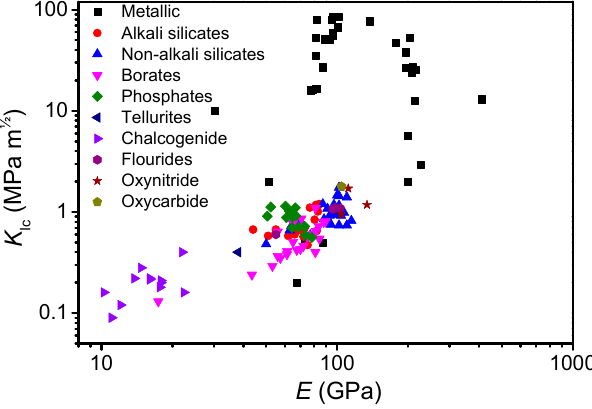
Figure 6. Dependence of measured fracture toughness ( K Ic ) on the measured Young’s modulus ( E ) for various glass systems (references are given in the text). Note that the axes are logarithmic. Errors in K Ic and E are estimated to be smaller than 0.05 MPa m 1 2 and 2 GPa,